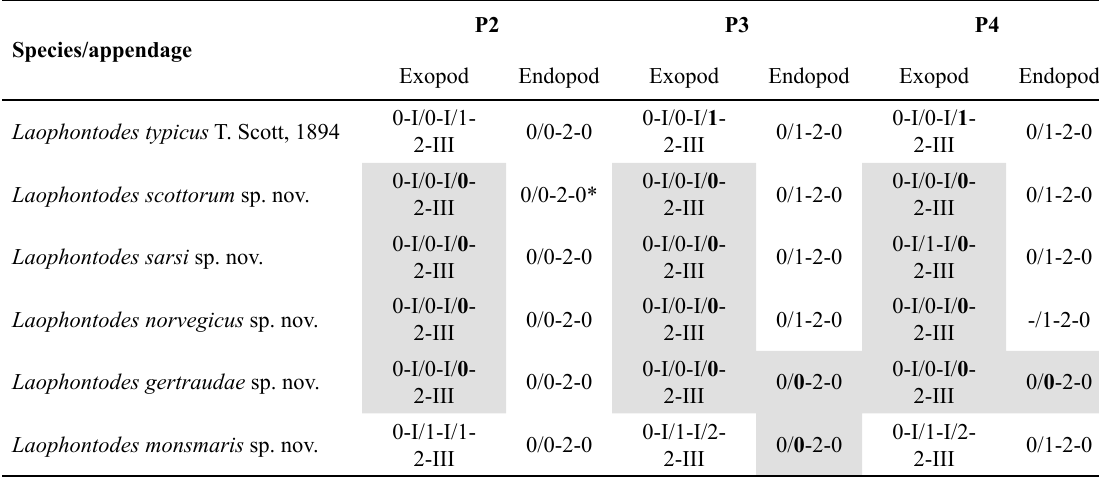
Table 1. Setation of female P2–P4 exps and enps for the 6 Laophontodes species examined. Bold numbers = derived states; grey-marked fields = most derived states. Arabic numerals indicate inner setae; roman numerals indicate outer spines. *According to Scott